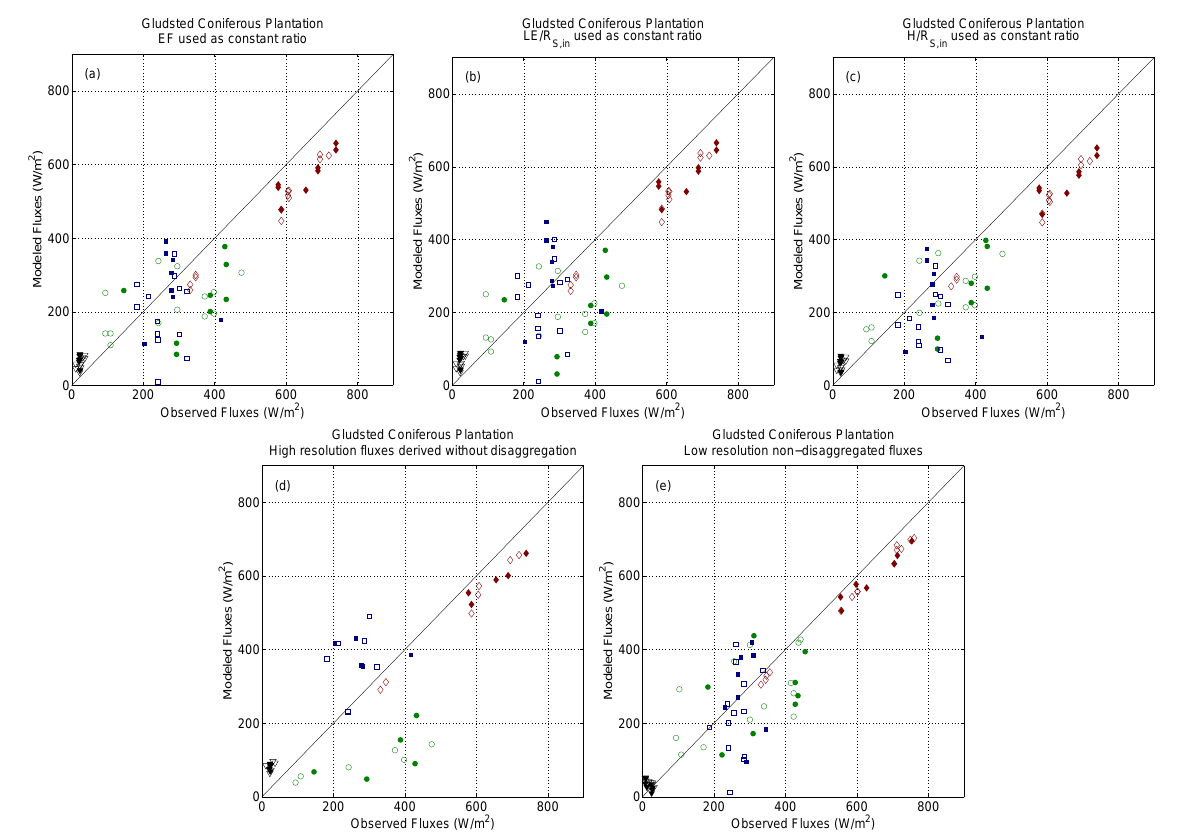
Figure 7. Comparison of modelled vs. observed fluxes at the Gludsted coniferous plantation. Modelled fluxes are instantaneous at the time of satellite overpass and observed fluxes are 30min averaged EC measurements. The three approaches used for determining the constant ratio during the disaggregation are: (a) evaporative fraction, (b) LE /R s, in , (c) H/R s, in . Panel (d) shows high-resolution fluxes derived with TSEB model without disaggregation. The modelled fluxes in those panels are produced at 30m spatial resolution and are aggregated to EC footprint. Panel (e) shows the low-resolution, non-disaggregated fluxes modelled with DTD. Rectangles represent LE, circles represent H , triangles represent G and diamonds represent R n . Empty symbols indicate aggregated fluxes where pixels comprising 70% of EC footprint were present (S70 set), and full symbols where in addition there were no missing Landsat pixels within the MODIS pixels (S100 set).